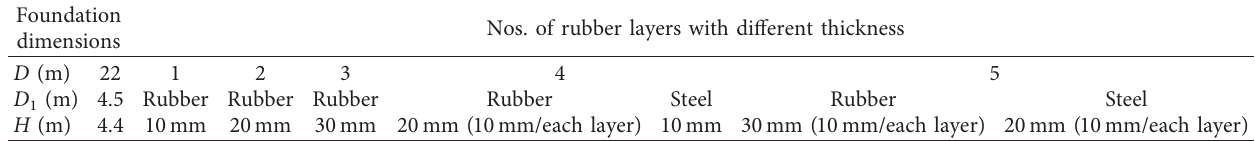
Table 2: Dimensions of the foundation and the thickness of rubber